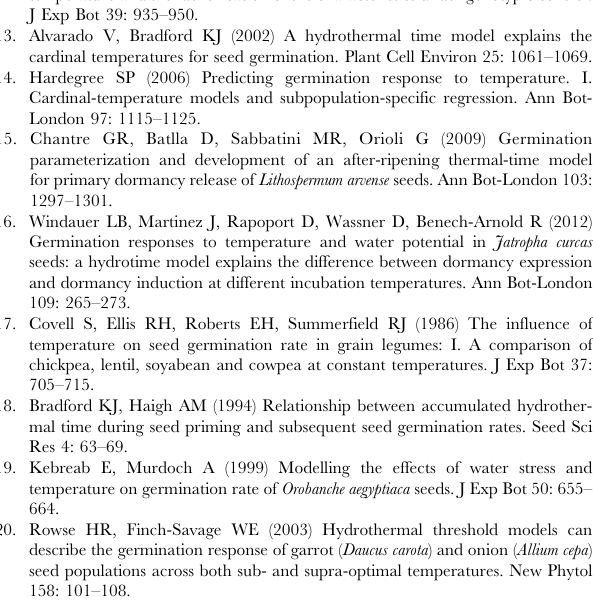
Figure S1 Change in final germination percentage of control seeds with germination temperature (A) and in seed viability during storage (B). The final germination was recorded after germination for 20 days at 5 and 10 u C and for 7